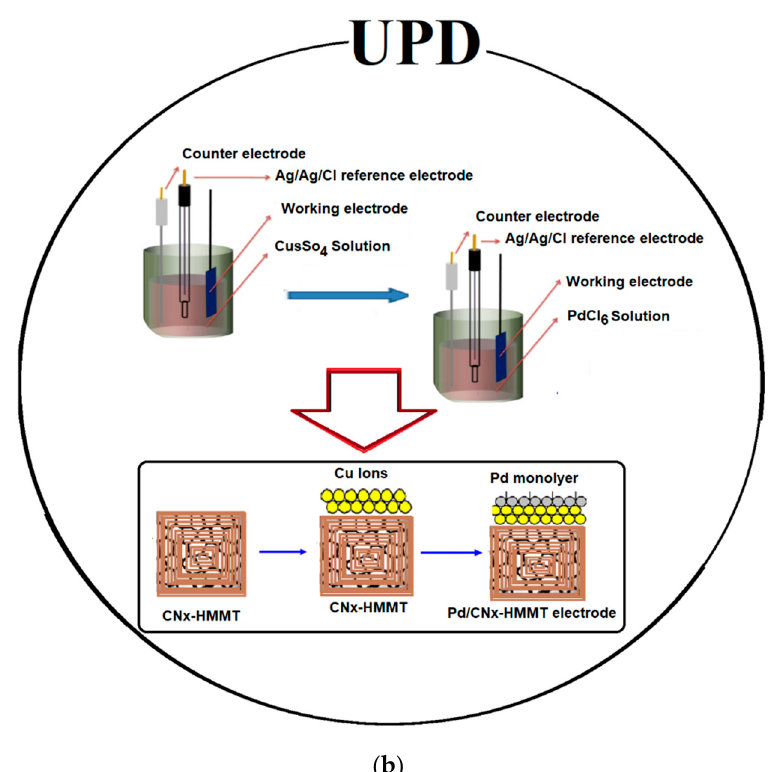
Figure 1. Synthesis of ( a ) nitrogen-doped electrocatalyst (CNx-HMMT) composite electrocatalyst, ( b ) Pd/CNx-HMMT composite electrocatalyst.